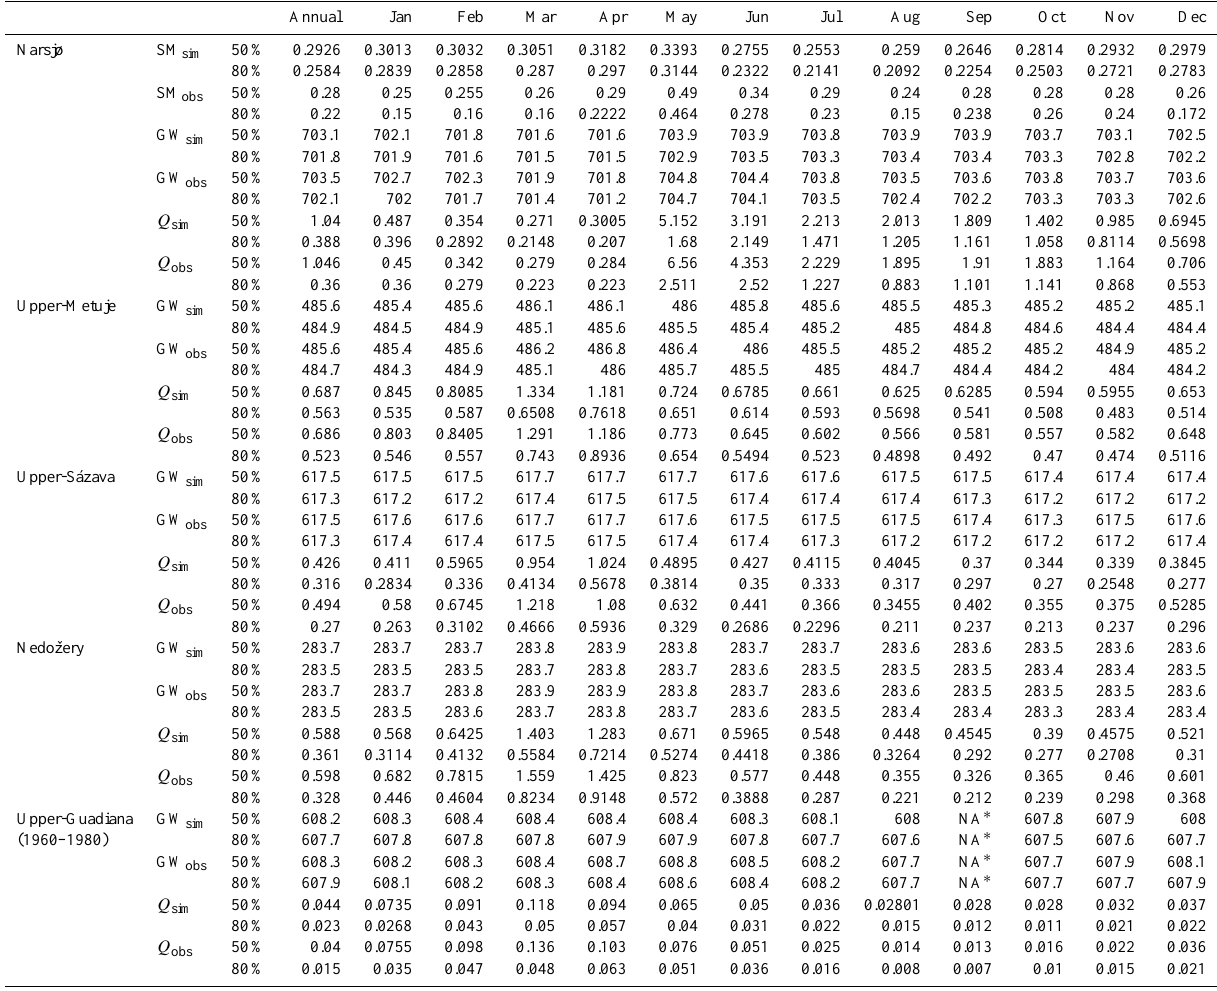
Table A1. Annual and monthly values of the 50th and 80th percentile of the duration curves of soil moisture (only Narsjø), groundwater and